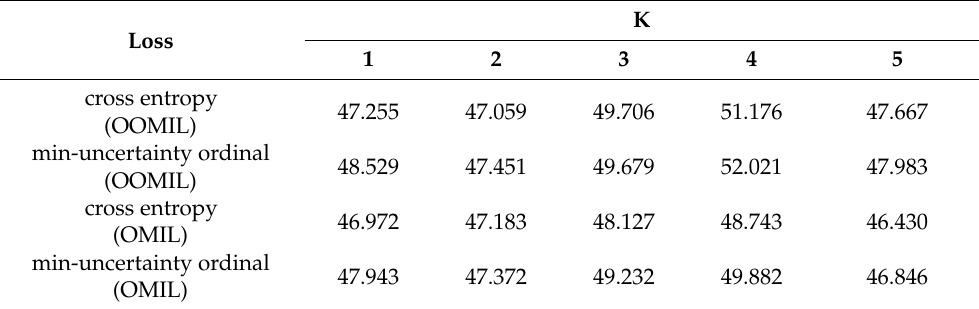
Table 7. Average test accuracy comparison of different loss functions on number set K for key instances. K ranges from 1 to